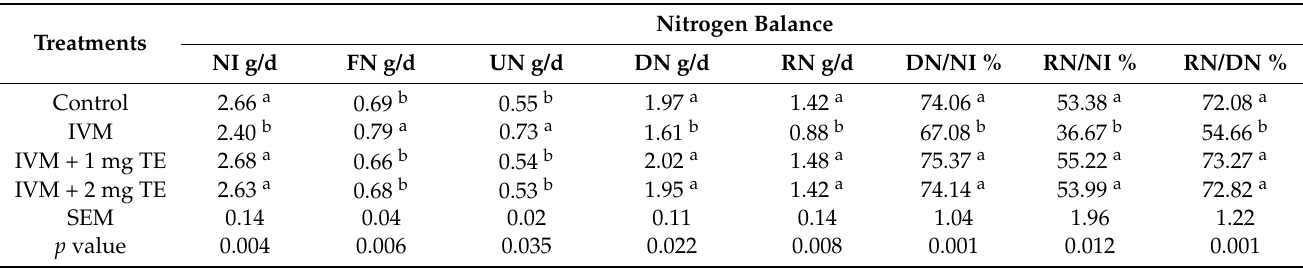
Table 4. The effect of combining Ivermectin injection with turmeric extract supplementation on the nitrogen balance of growing rabbits.